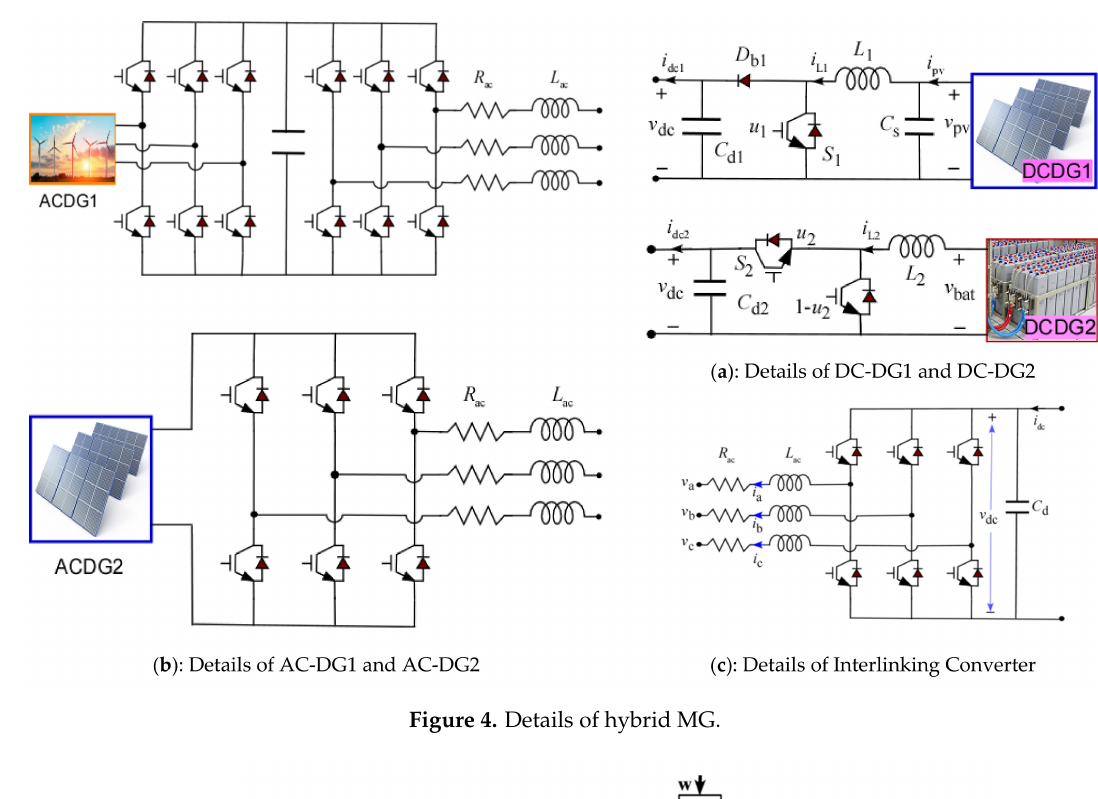
Figure 4. Details of hybrid MG.